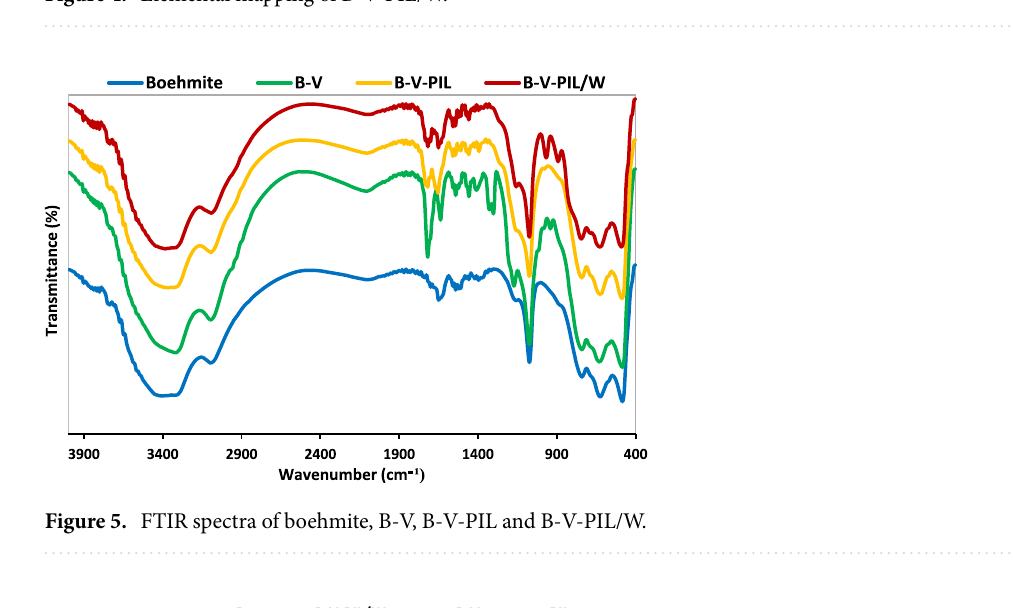
Figure 4. Elemental mapping of B-V-PIL/W.